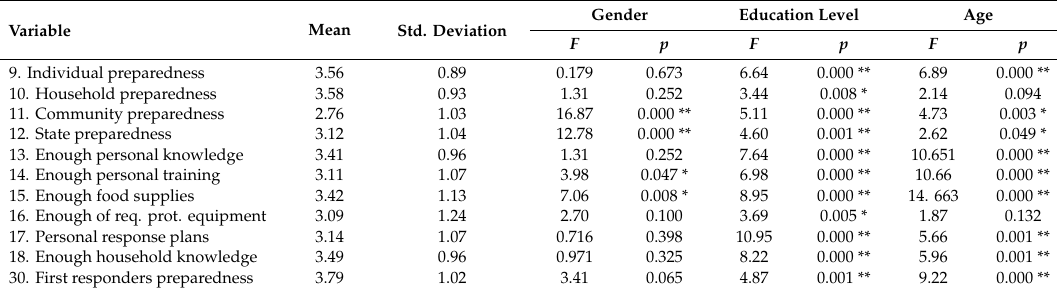
Table 4. One-way ANOVA results between gender, education level, and age variables and preparedness for coronavirus disease. Variable Mean Std. Deviation